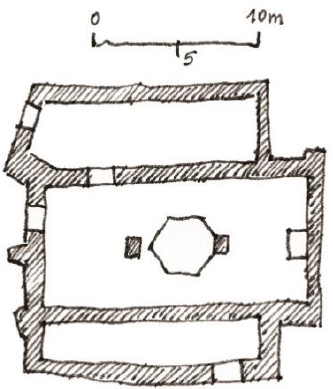
Figure 21. Vienna, second phase, before 1296. Sketch: Anja Premk.